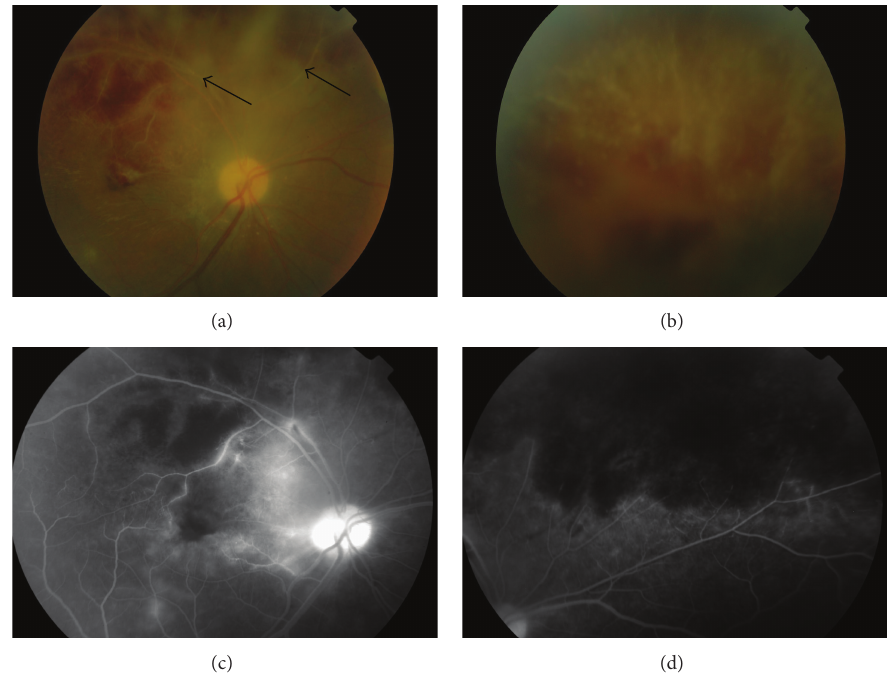
Figure 3: Fundus photographs of branch retinal vein occlusion secondary to Behc¸et’s disease. (a, b) Color images of the right eye showing vascular sheathing (arrows), exudates, and intraretinal hemorrhages. (c) Fluorescein angiography demonstrates multiple areas of hypofluorescence corresponding to areas of retinal hemorrhage and (d) upper retinal quadrant hypoperfusion secondary to vasooclusion.